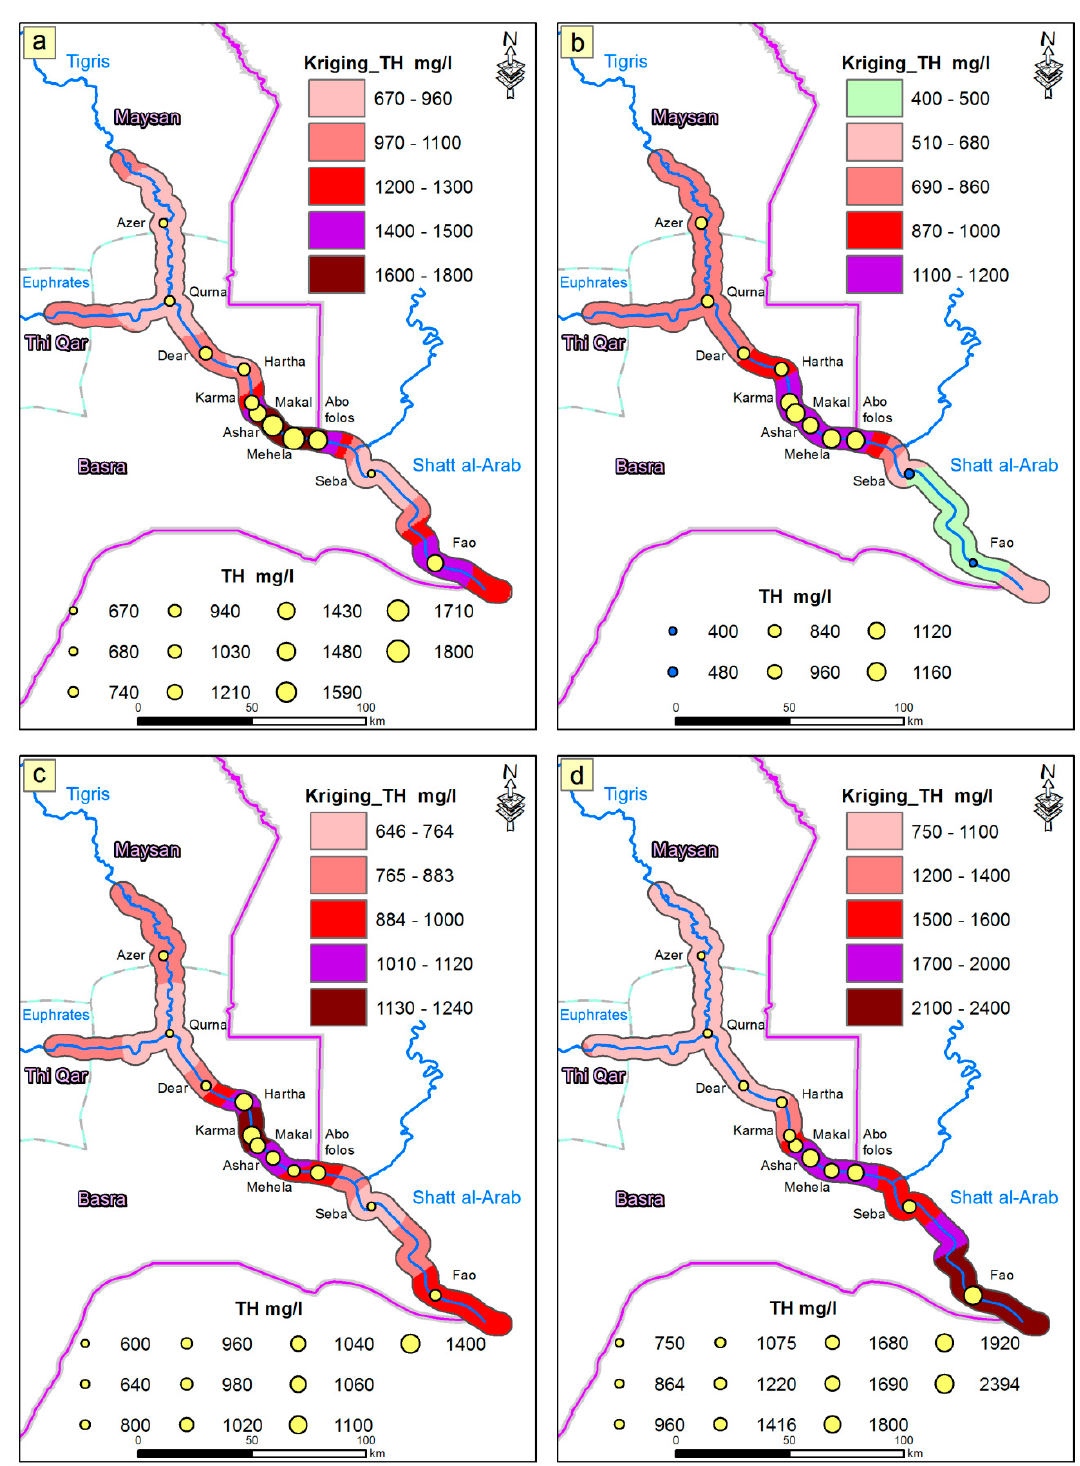
Figure A3. Spatial distributions of TH concentrations by kriging ( a ) winter 2018 ( b ) spring 2019 ( c ) summer 2019 ( d ) autumn 2019.